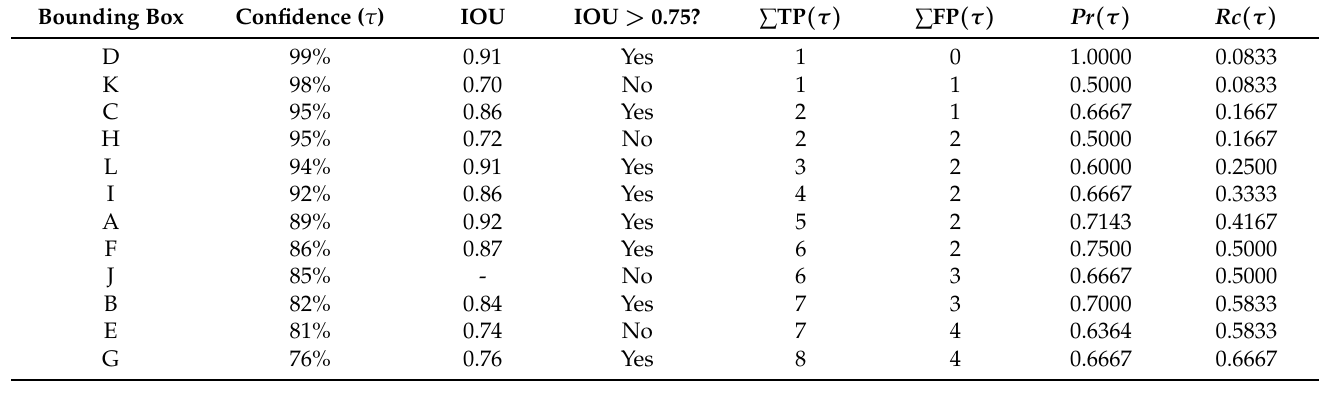
Table 4. Precision and recall values for detections in Figure 3, that contain a total of 12 ground truths, considering an IOU threshold t = 0.75.